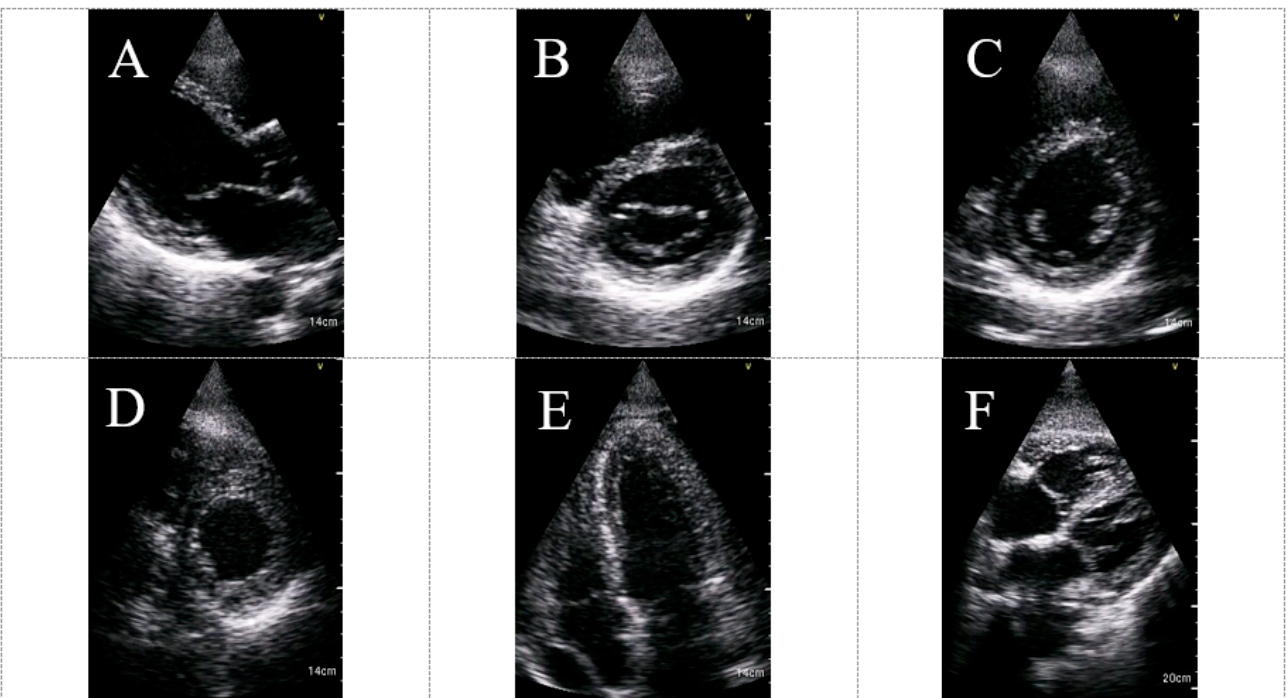
Figure 4. HUD acquired echocardiographic images in COVID-19 patients: parasternal long axis view ( A ), parasternal short axis view (MV level) ( B ), parasternal short axis view (PM level) ( C ), parasternal short axis view (apex level) ( D ), apical four chambers view ( E ) and subcostal view ( F ). * The imaged were acquired using the Vscan Extend with the Dual Probe, General Electric. Abbreviations: HUD, hand-held ultrasound device; MV, mitral valve; PM, papillary